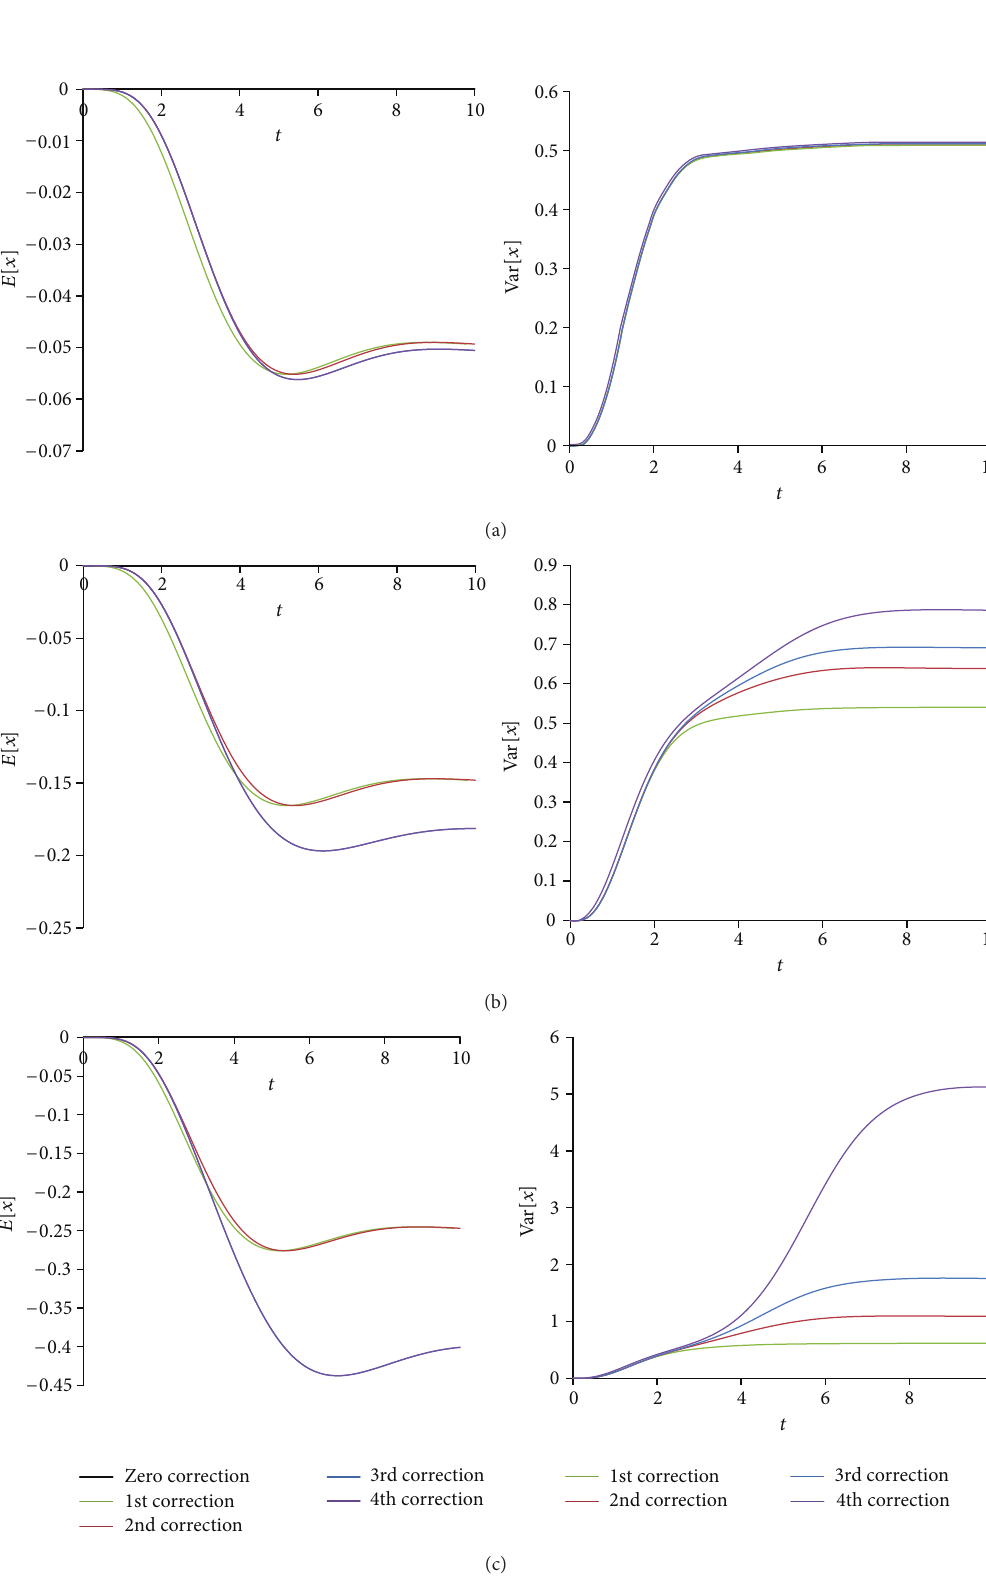
Figure 10: The third-order response mean and variance for (a) 𝜀 = 0.1 , (b) 𝜀 = 0.3 , and (c) 𝜀 = 0.5